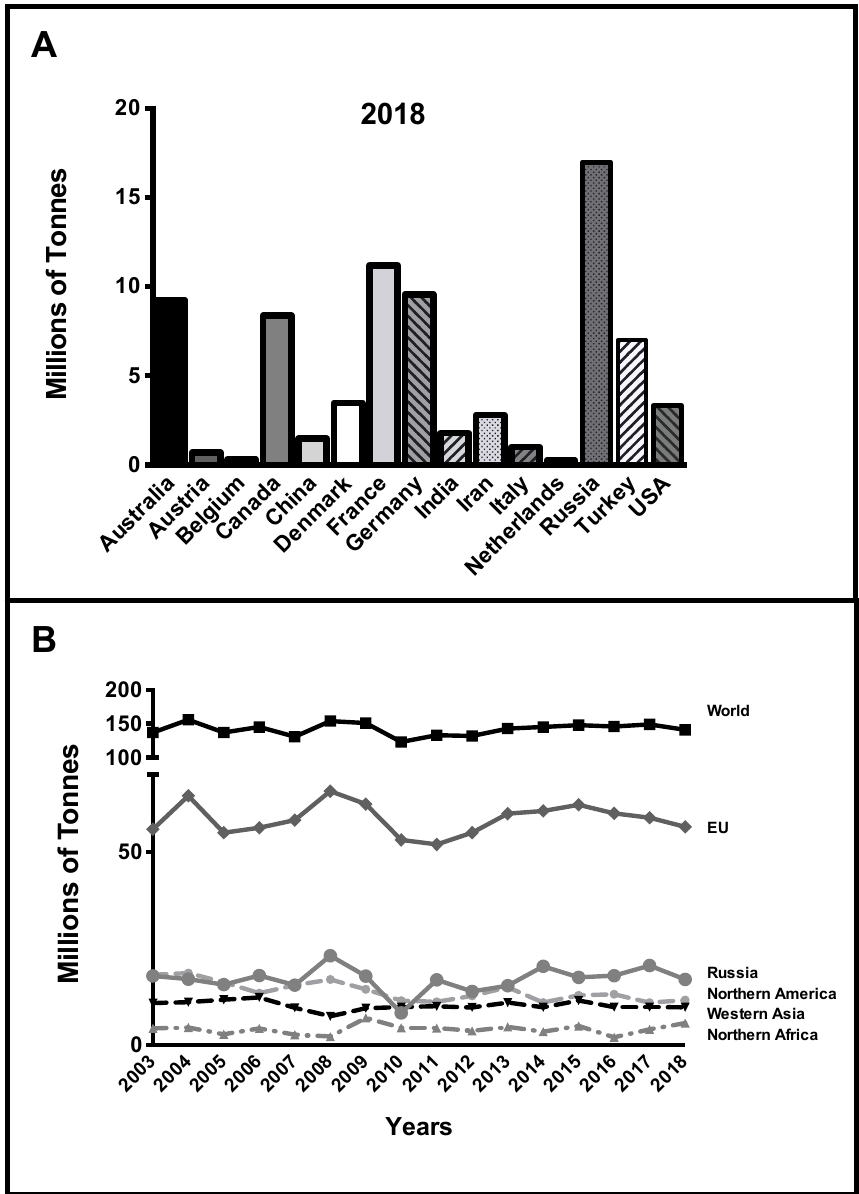
Figure 1. ( A ) Barley production in different countries in 2018. ( B ) Evolution of barley production from 2003 to 2018 in different countries and macro-areas. The figure was obtained from data present in the FAO database [6] (http://www.fao.org/faostat/en/#home, accessed on 1 November 2021).